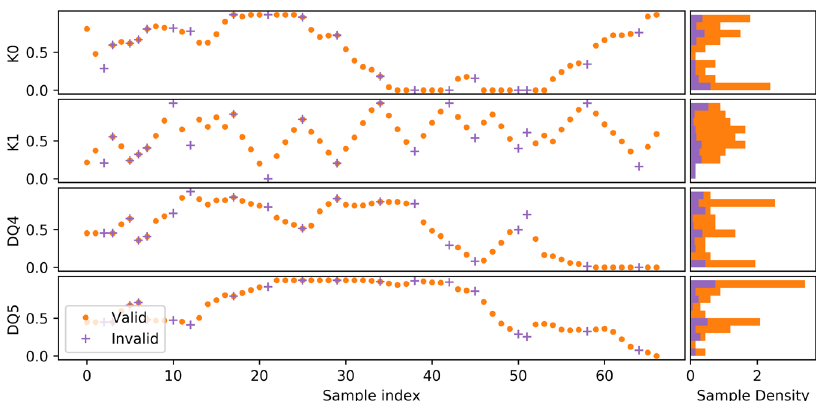
Fig. 4 Tracing exploration path through input parameter space. Normalized parameter values as a function of sample index during Bayesian exploration for all four input parameters. Corresponding sample density histograms are shown on